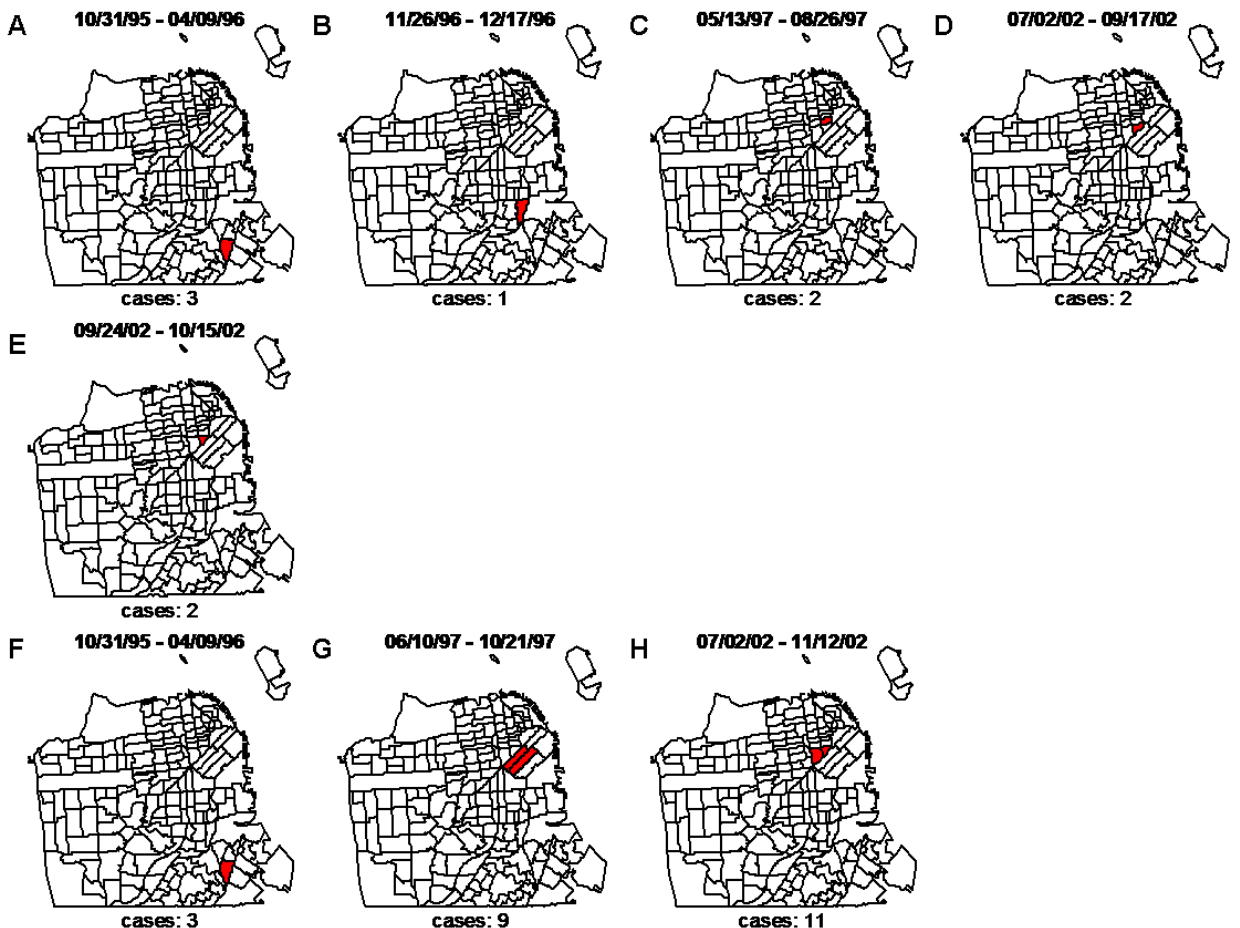
Figure 3. Significant signals detected by the method applied to the confirmed p9outbreaks using individual addresses (A–E) and census tract centroids (F–H). San Francisco map is partitioned by census tract where tracts shaded red represent the location of the significant signal detected for the specified dates in Table 1. To protect patient confidentiality, only the census tracts in plots A–E are shaded, as opposed to highlighting the exact